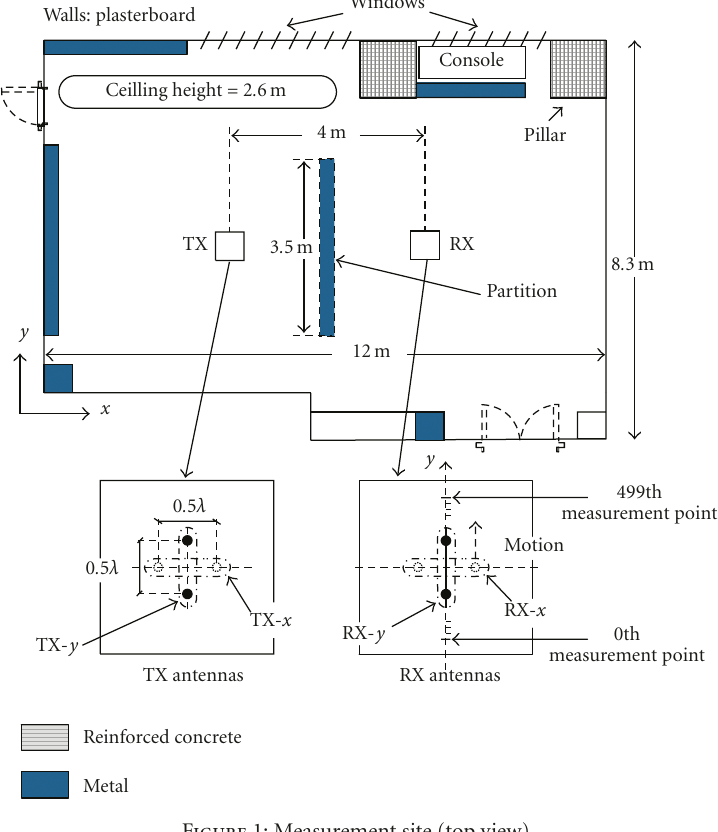
Figure 1: Measurement site (top view).